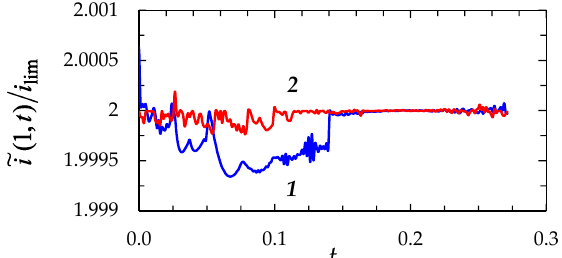
),1(~ iti obtained from the lim